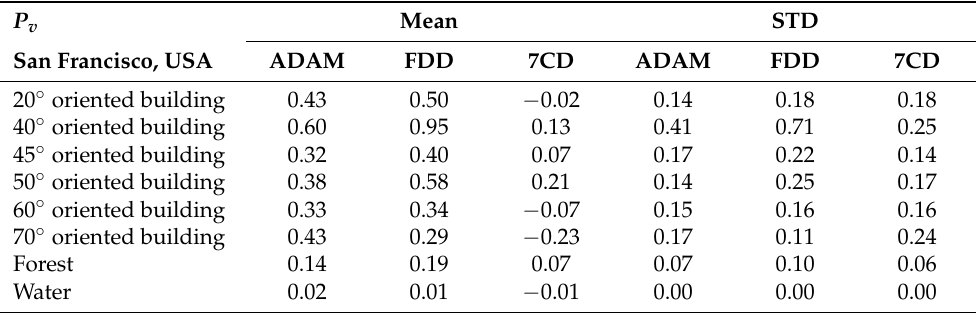
Table 5. The statistical results of volume scattering power P v in 8 types of samples over San Fran- cisco,